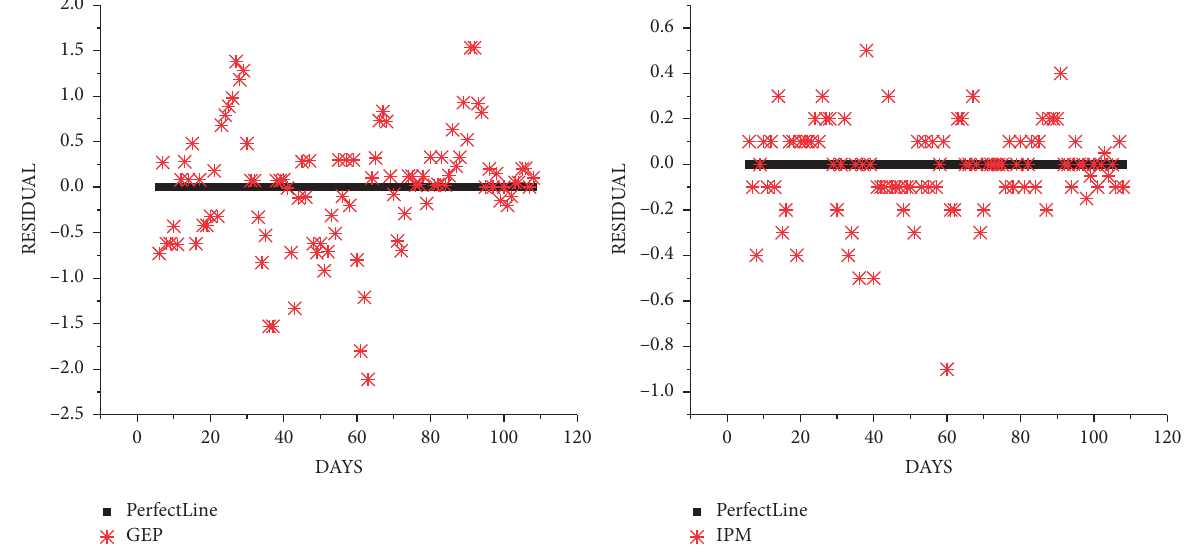
Figure 6: GEP-IPM prediction result residual of leek